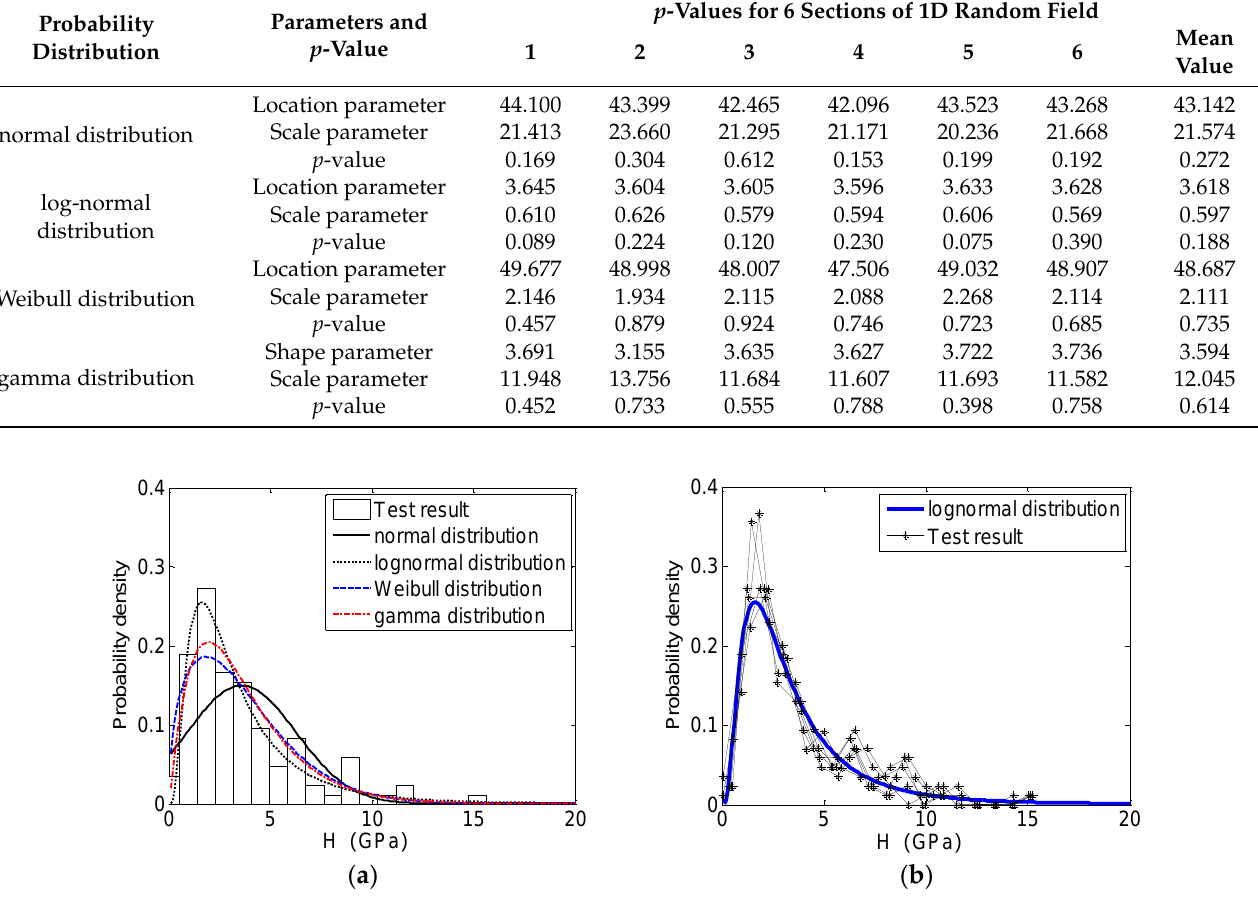
Table 4. Pointwise parameters estimation for the nano-modulus of the ITZ.